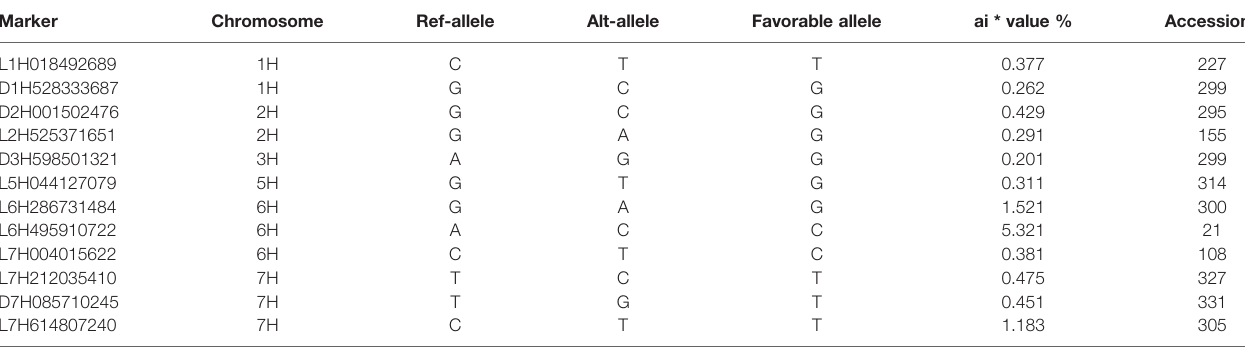
TABLE 3 | Favourable alleles, their phenotypic effects (ai), and the number of accessions. Marker